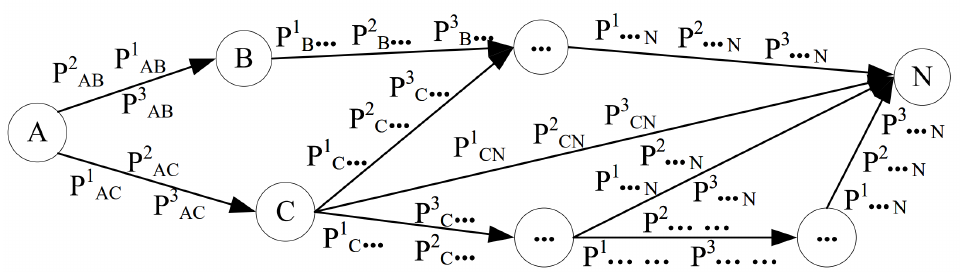
Figure 1. Host Probability Distribution